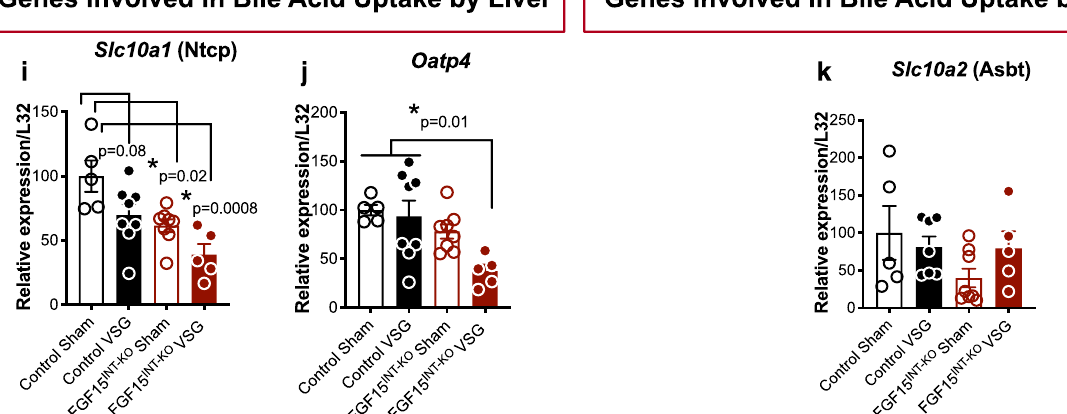
Fig. 6 Intestinal FGF15 regulates enterohepatic bile acid metabolism following VSG. a Total plasma bile acid levels. b Cecal contents total bile acid levels. c . Hepatic total bile acids. d Plasma bile acid composition. e Hydrophobic plasma bile acid levels. Hepatic RNA expression of bile acid synthesis genes. f Cyp7a1 , g Cyp8b1 and h Cyp27a1 . Hepatic RNA expression of bile acid uptake genes i Slc10a1 (coding for Ntcp) and j Oatp4 . k Ileum RNA expression of bile acid uptake gene Slc10a2 (coding for Asbt). Animal number for ( b ), ( c ), ( f – j ): Control Sham ( n = 5), Control VSG ( n = 8), FGF15 INT-KO Sham ( n = 8), FGF15 INT-KO VSG ( n = 5). Animal number for ( a ), ( d ), ( e ): Control Sham ( n = 5), Control VSG ( n = 7), FGF15 INT-KO Sham ( n = 6), FGF15 INT-KO VSG ( n = 5). Animal number for k: Control Sham (n = 5), Control VSG ( n = 7), FGF15 INT-KO Sham ( n = 8), FGF15 INT-KO VSG ( n = 5). Data are shown as means ± SEM. * p < 0.05 (two-way ANOVA with Tukey ’ s post hoc test).